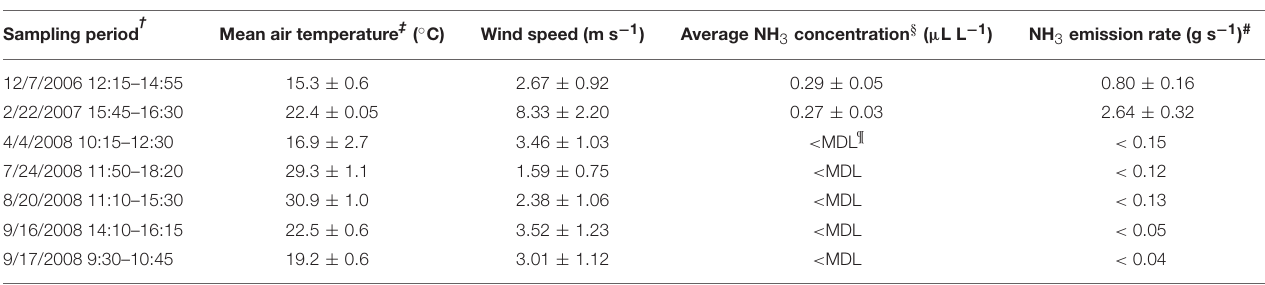
TABLE 3 | Summary of temperatures, wind speed, and NH 3 emission rates from the swine farm. Sampling period